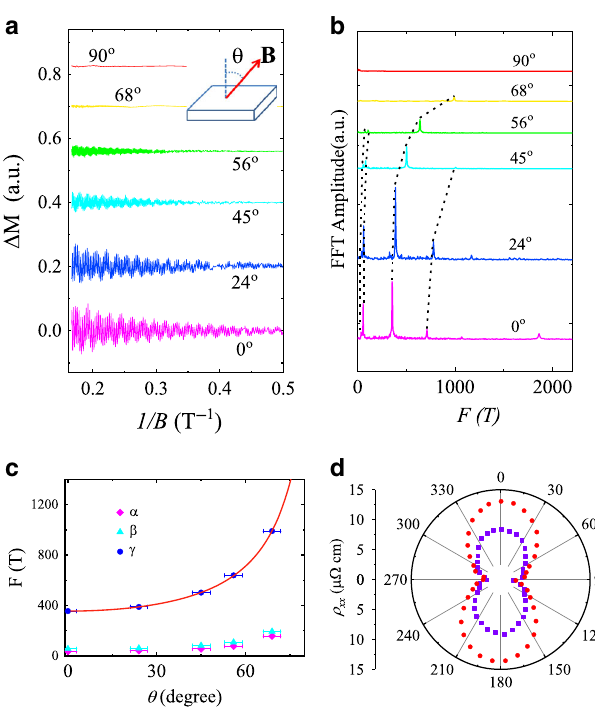
Fig. 3 Angle-dependent dHvA oscillation and in-plane MR of BaGa 2 . a Angle-dependent dHvA oscillations at 1.8 K. b Corresponding FFT spectra with θ varying from 0° to 90°. c FFT frequencies as a function of angle. Solid red line is the fi tting curve with equation F = F 0 /cos θ . Error bars are estimated from sample holders and de fi ned as s.d. d Polar plot of MR at 9 T (violet dots) and 14 T (red dots) with B always vertical to I at 2.5 K.